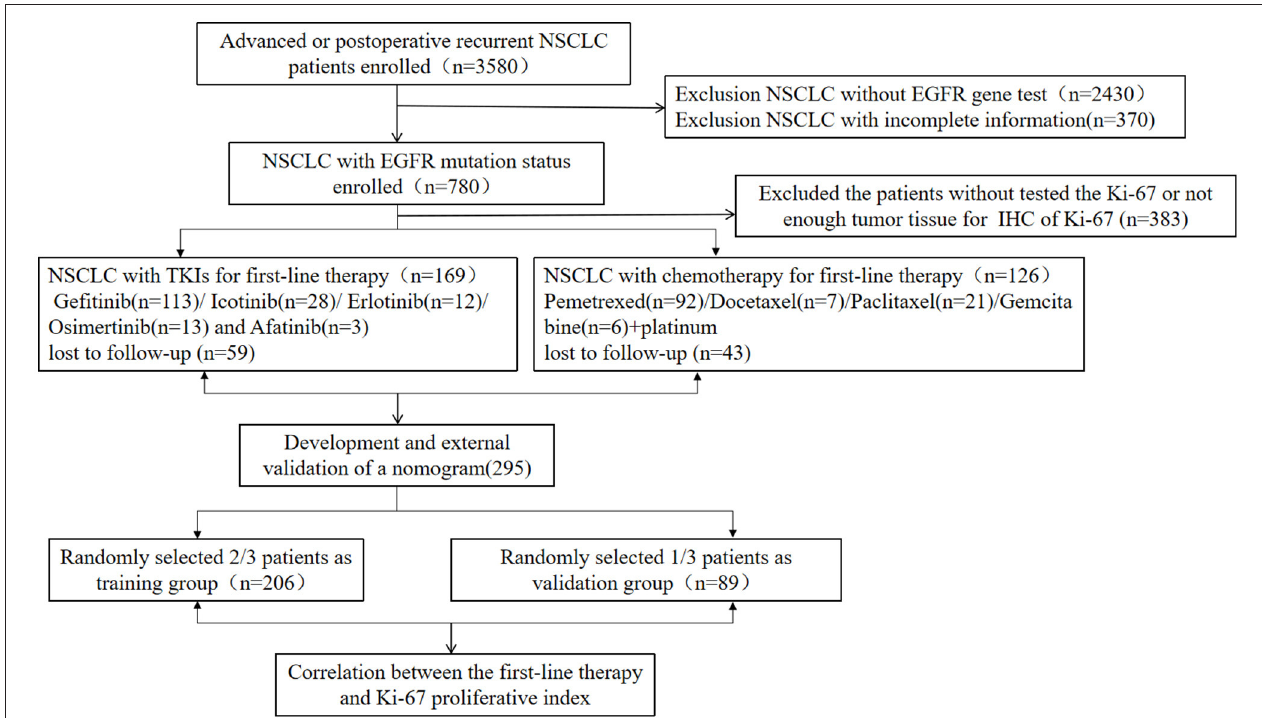
FIGURE 1 | Consort diagram, enrollment, and outcome.